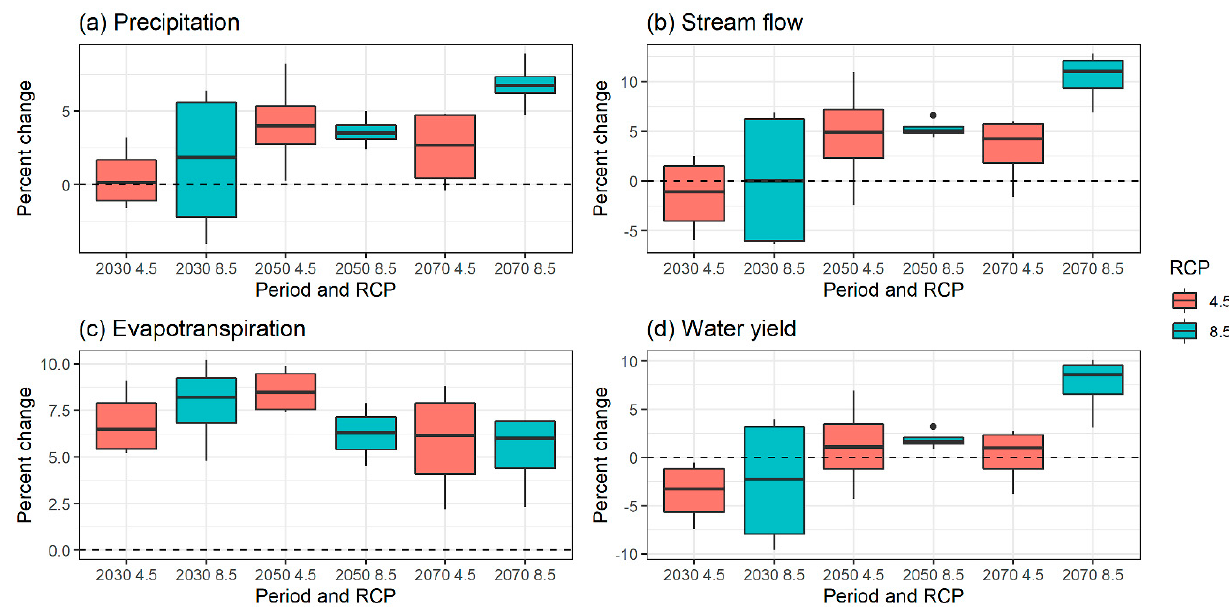
Figure 4. Projected annual changes in water balance components ( a ) precipitation, ( b ) streamflow, ( c ) evapotranspiration, and ( d ) water yield in Deckers Creek Watershed, Morgantown, West Virginia, USA. Box and whisker plot represent ensemble percentage change for four GCMs under two RCPs (RCP 4.5 and RCP 8.5). Projections are for 3 future periods of 20-year interval (2030s = 2031 − 2050, 2050s = 2051 − 2070, 2070s = 2071 − 2090). The black dotted line represents the historical baseline of 1980–1999.